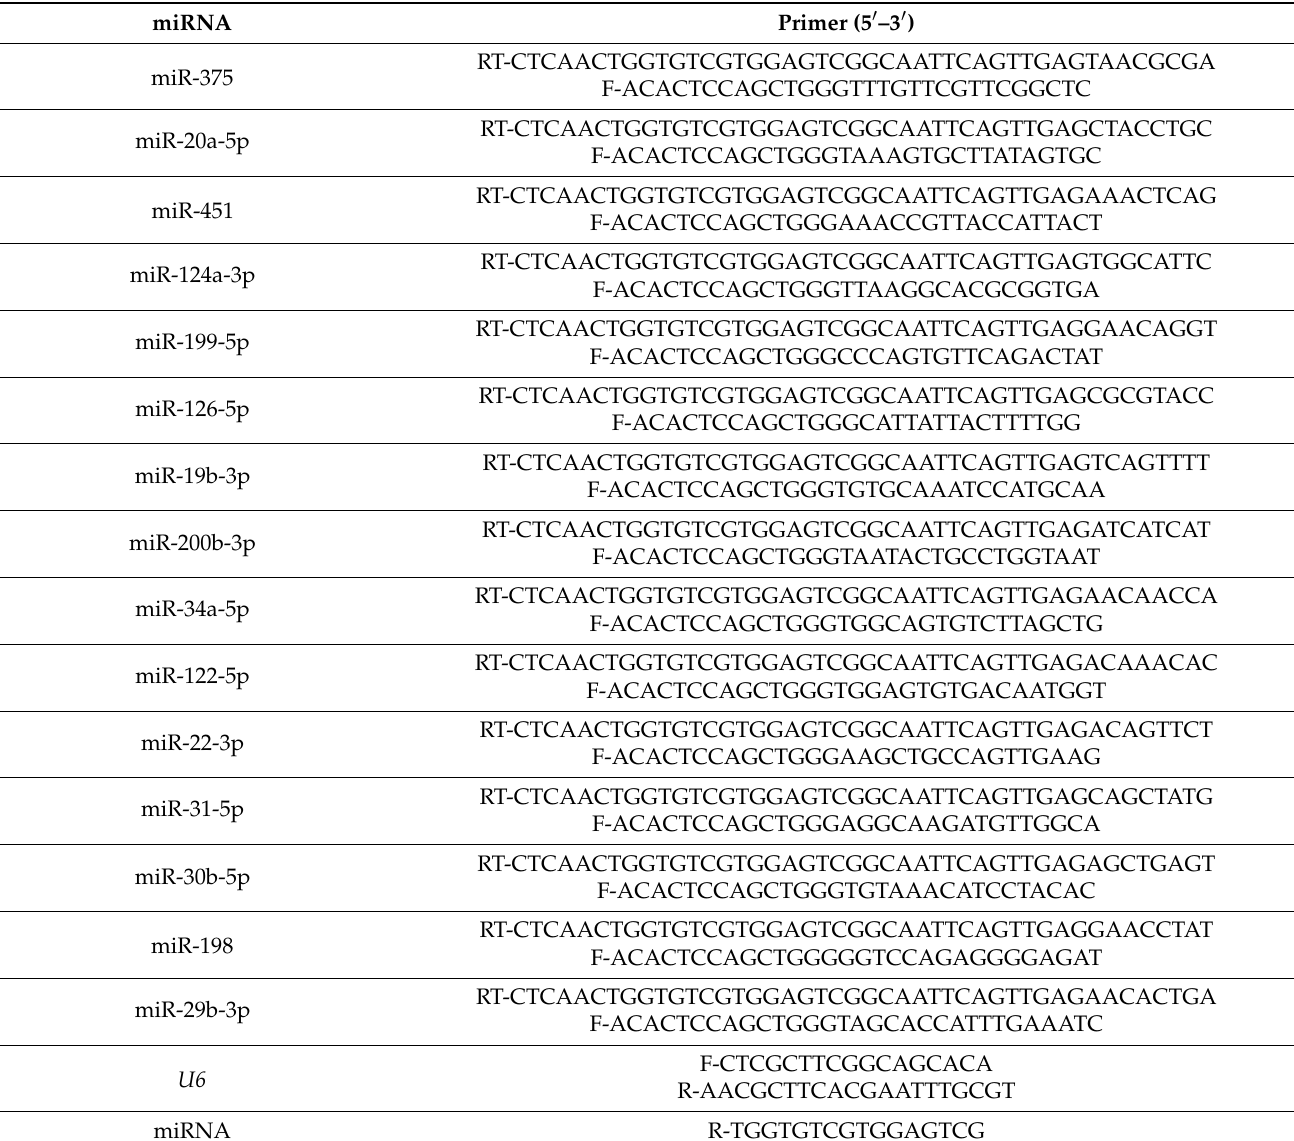
Table 1. Primers used to detect microRNAs (miRNAs) expression levels with